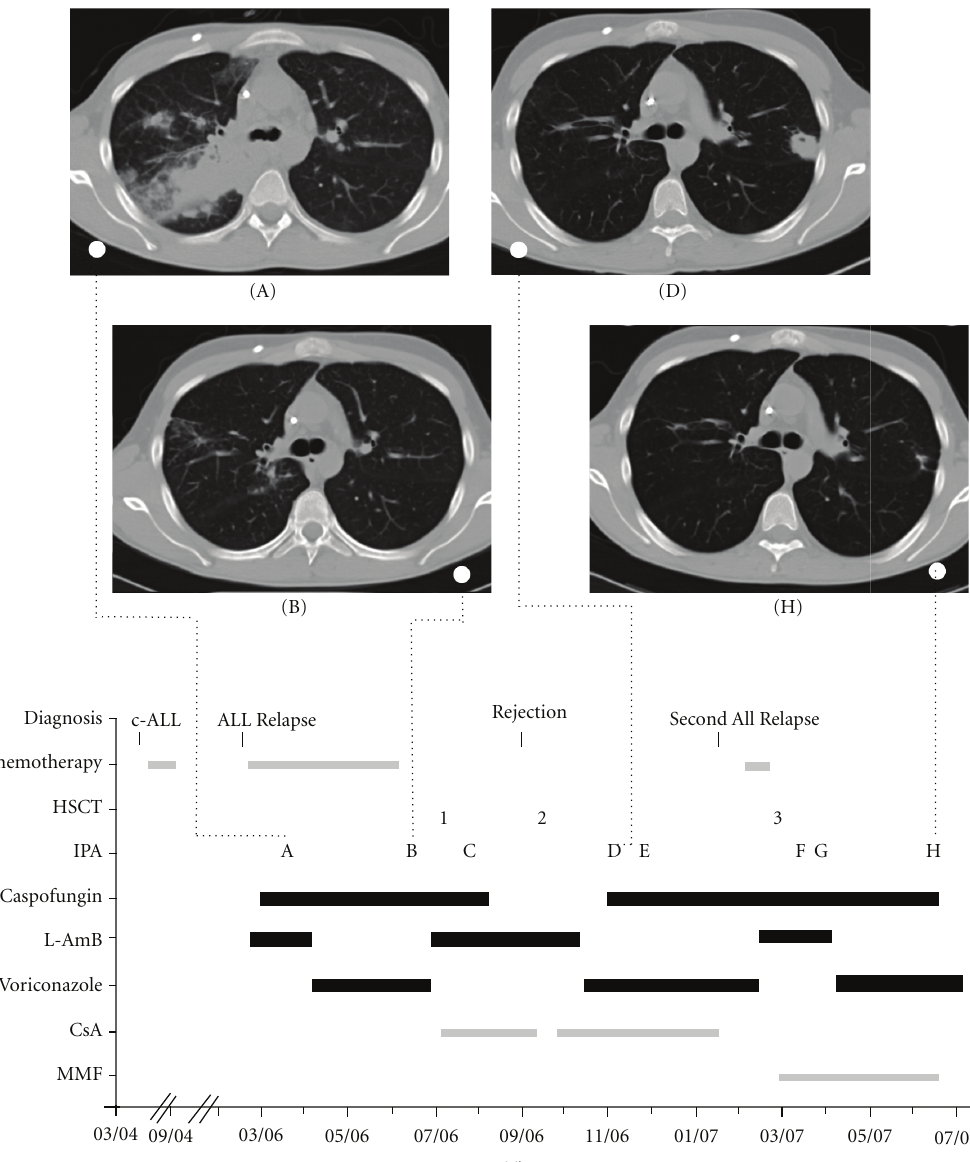
Figure 1: Drug regimens and development of invasive pulmonary aspergillosis (IPA). Important milestones are marked with letters: (A) Diagnosis of aspergillosis with extensive lesions in the apical right lung. (B) Improvement of lesions in the apical right lung. (C) Improvement of all lesions in the right lung with start of scarring. (D) Worsening of the lesions in the right lung and a new lesion in the left lung segment 3 under monotherapy with L-AmB or voriconazole. (E) and (F) Improvement of all lesions. (G) Progression of all lesions. (H) Almost complete disappearance of pulmonary aspergillosis. Abbreviations: HSCT, hematopoietic stem cell transplantation; L-AmB, liposomal amphotericin B; CsA, cyclosporin A; MMF,